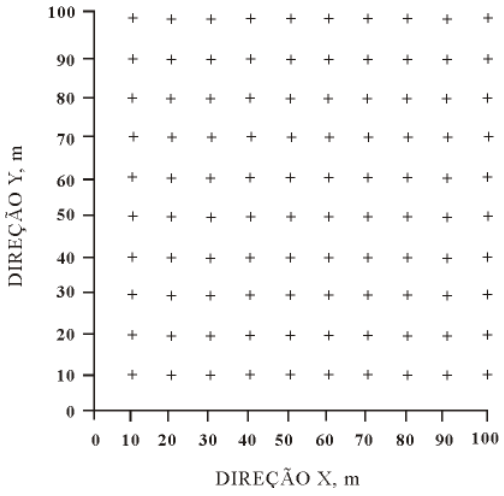
Figura 1. Croqui da área experimental (sinais + indicam os pontos